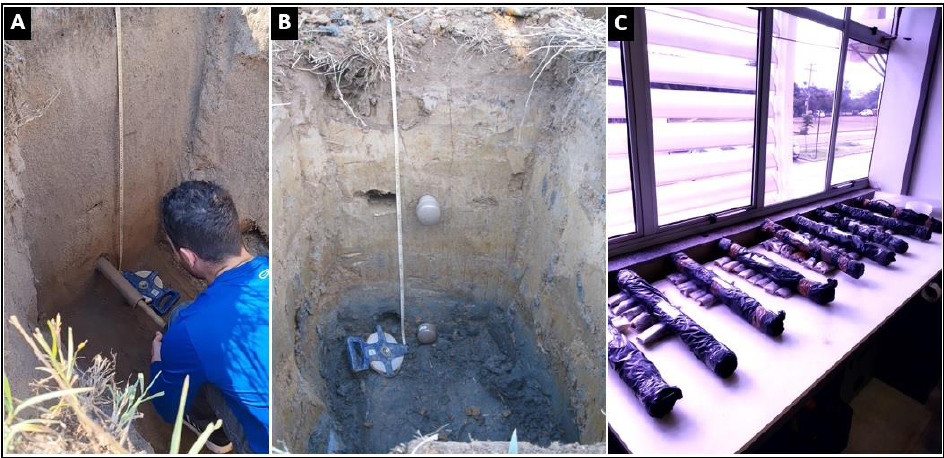
Figure 2. Example of sample collection procedure for OSL dating. ( A ) Horizontal introduction of the PVC pipe at a certain depth of interest after opening the trench; ( B ) Pipes inserted and capped, ready to be taken out of the trench; ( C ) Pipes sealed in the laboratory ready to be sent for dating by OSL. (Photo by: L. Lämmle,